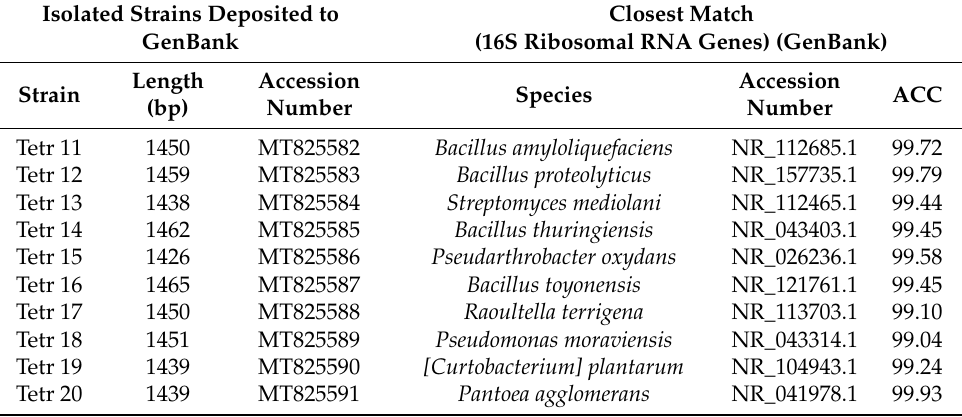
Table 2. Sequence similarities of endophytic bacteria isolated from leaves of Tetragonia tetragonioides (Pall.) Kuntze with sequences registered in